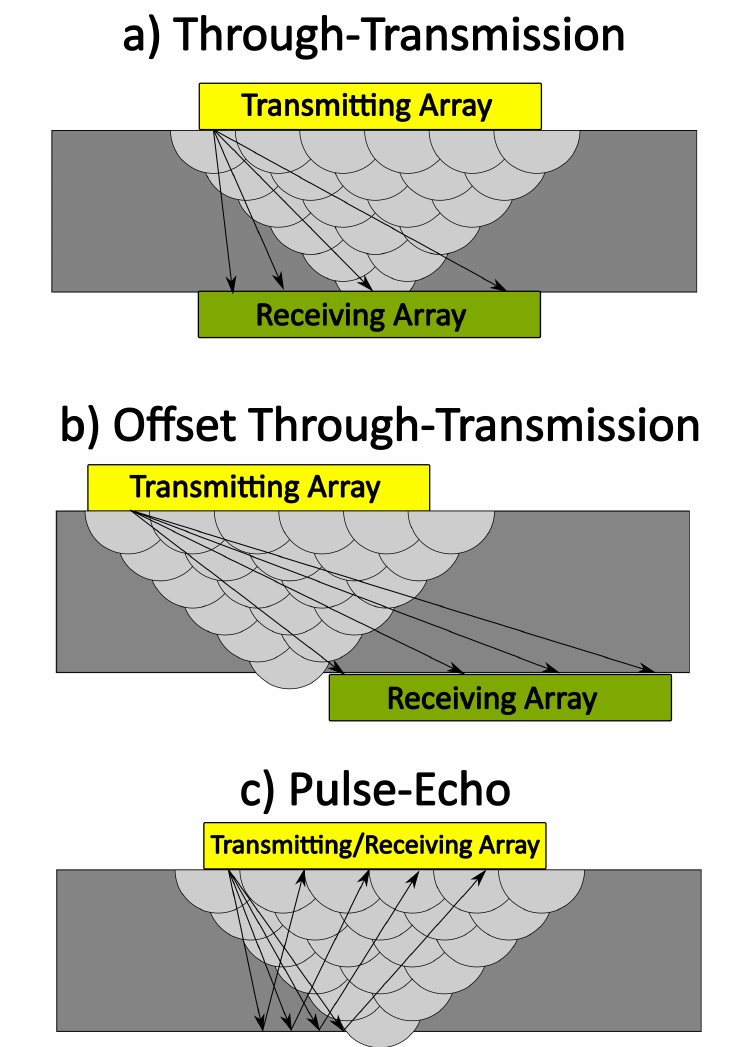
Figure 3. Transducer elements are positioned in three configurations: ( a ) a through-transmission configuration, where an array of 32 transmitting elements are placed on the top of the weld, and an array of 32 receiving elements are placed directly opposite on the bottom of the weld; ( b ) an offset through-transmission configuration, where transmitting elements are placed at the top of the weld and the receiving elements are placed at the bottom, but offset to the right by 20 mm (to avoid the weld bead); ( c ) a pulse-echo configuration, where the array is placed on top of the weld, and each transducer element acts both as a transmitter and a